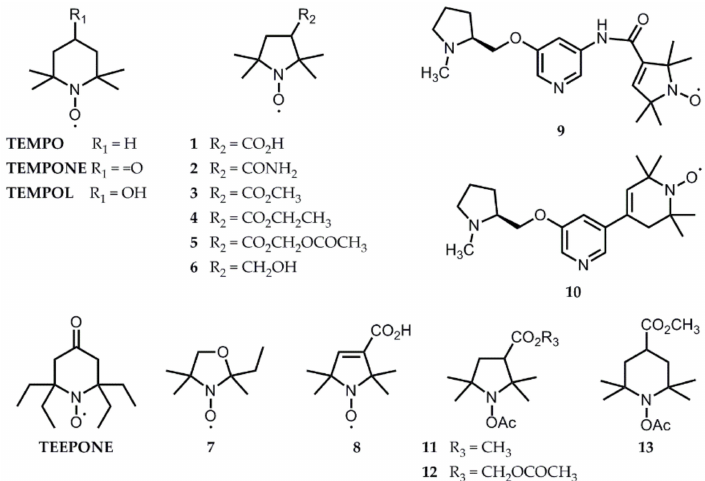
Figure 9. Structures of nitroxide and acyl-protected hydroxylamine probes mentioned in this